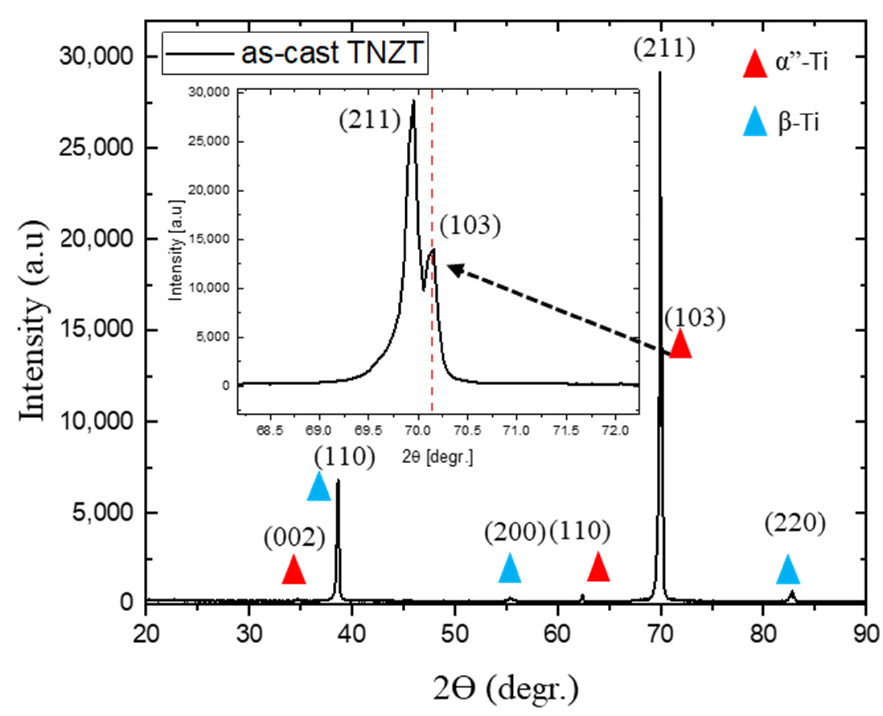
Figure 2. XRD pattern of the as-cast TNZT sample.